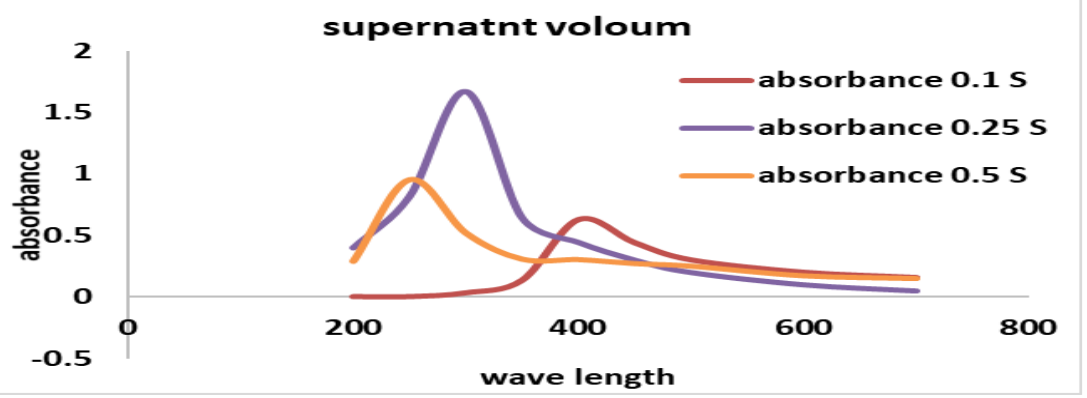
Figure 6. UV absorbance curve of final mixture after incubation with different supernatant volume 10, 25, 50 % of total mixture.